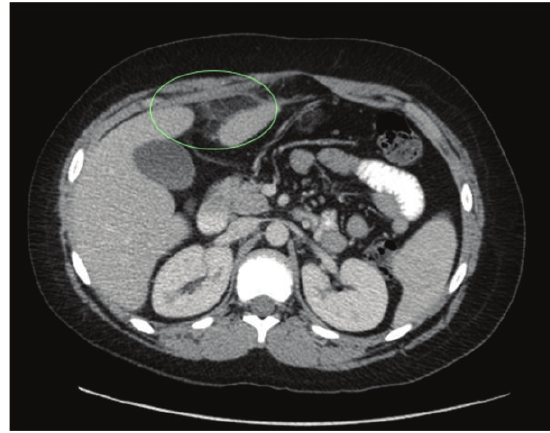
Figure 2: CT abdomen and pelvis, coronal view. Torsion of lipomatous appendage of falciform ligament